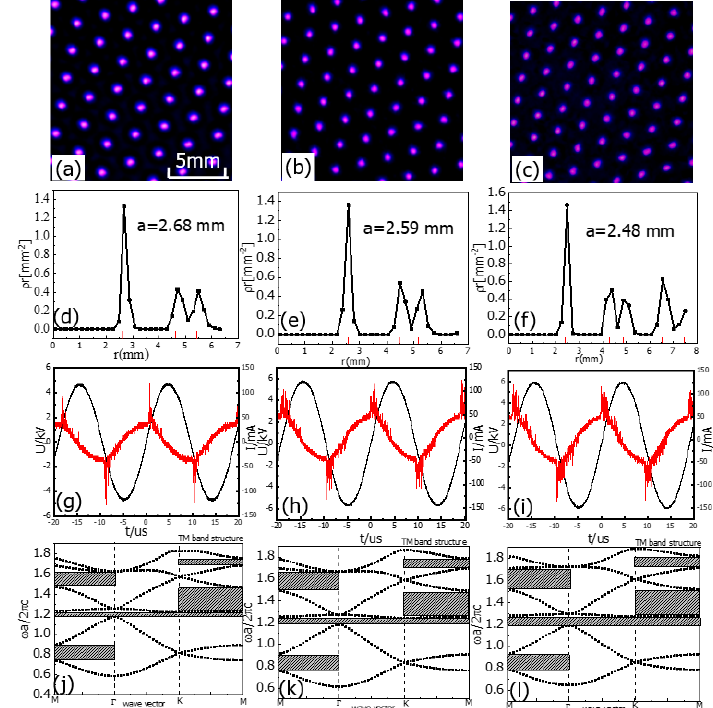
Figure 5. Plasma photonic crystals with reduced lattice constant when increasing of the applied voltage ( a – c ), the corresponding pair correlation functions ( d – f ), the voltage-current waveforms ( g – i ), and the corresponding band diagrams ( j – l ). The discharge parameters are: ( a ) U = 4.8 kV, p = 14 W ( b ) U = 5.8 kV, p = 30 W ( c ) U = 6.0 kV, p = 34 W. f = 53 kHz, p = 230 torr, d = 2.0 mm, t = 40 ms. The working gas is 40% Ar and 60% air. The red short lines at the bottom of ( d – f ) indicate the positions of ρ (cid:2928) peaks for ideal triangular lattices. The electron density is set as 10 15 cm − 3 [36,38–40], υ (cid:2923) = 60 GHz.